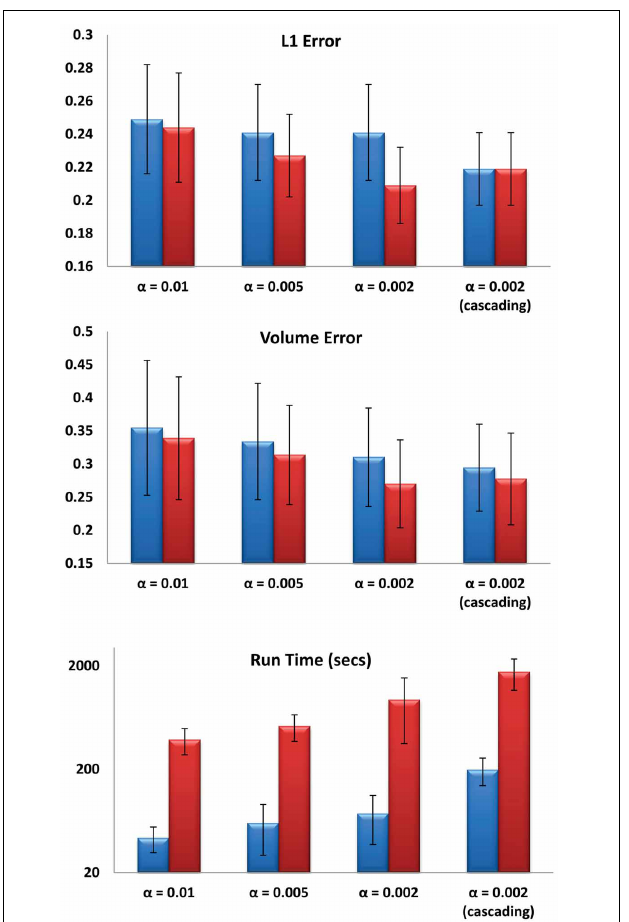
FIGURE 3 | Mean and standard deviation of mean L 1 error (top), mean volume error (middle) and LDDMM running times (bottom) calculated from a population of 16 subjects for different values of α , T = 1 (blue) and T = 10 (red). Mean errors were calculated using 7 pairs of